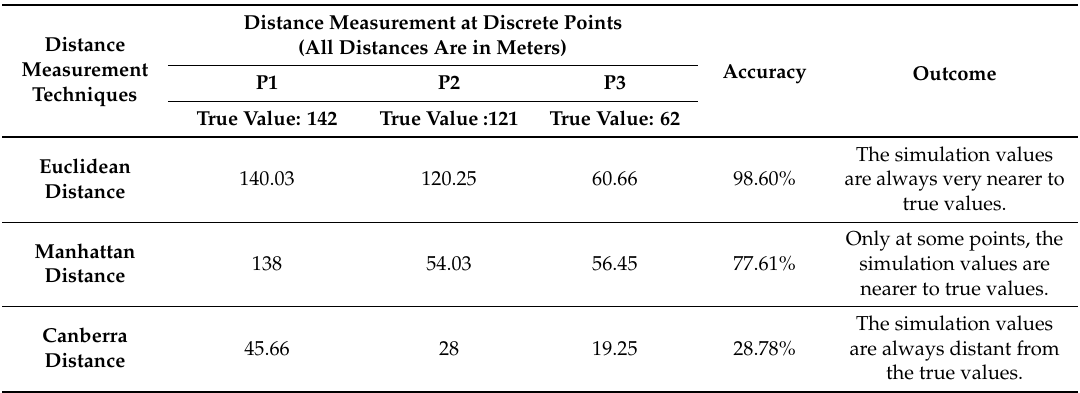
Figure 15. Distance measurement techniques: ( a ) Euclidean distance; ( b ) Manhattan distance; ( c ) Canberra distance. Table 4. Experiment